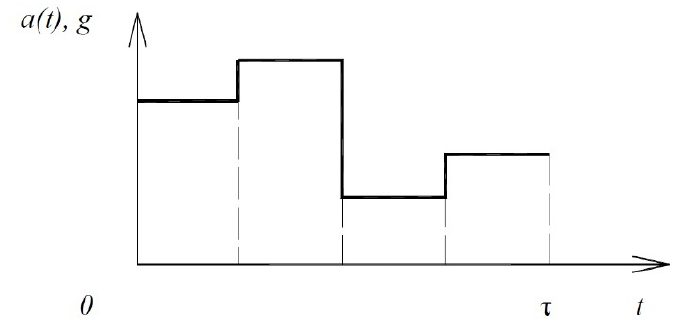
Figure 9. The law of change of linear acceleration.